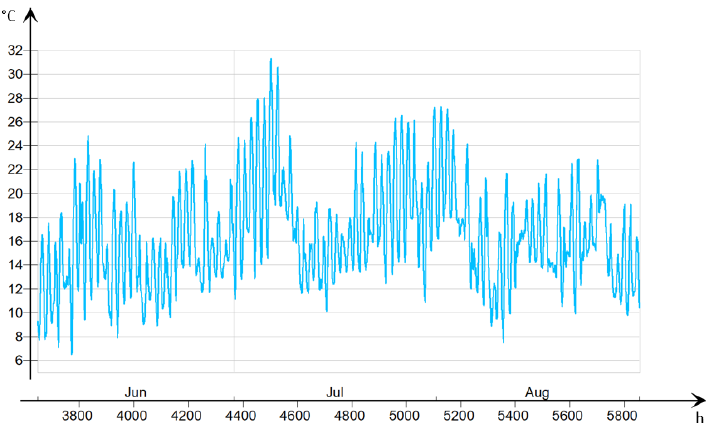
Figure 6. Outdoor air temperature during the simulation period. Table 6. Schedule of ventilation and internal heat gains.